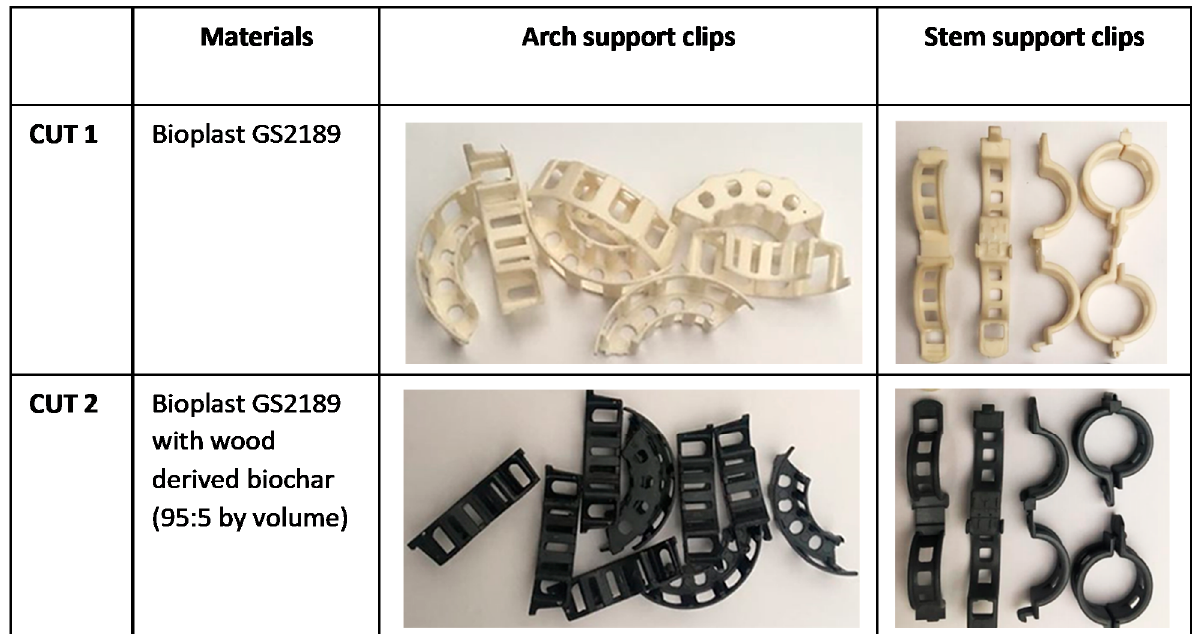
Figure 2. Arch and stem support clips.